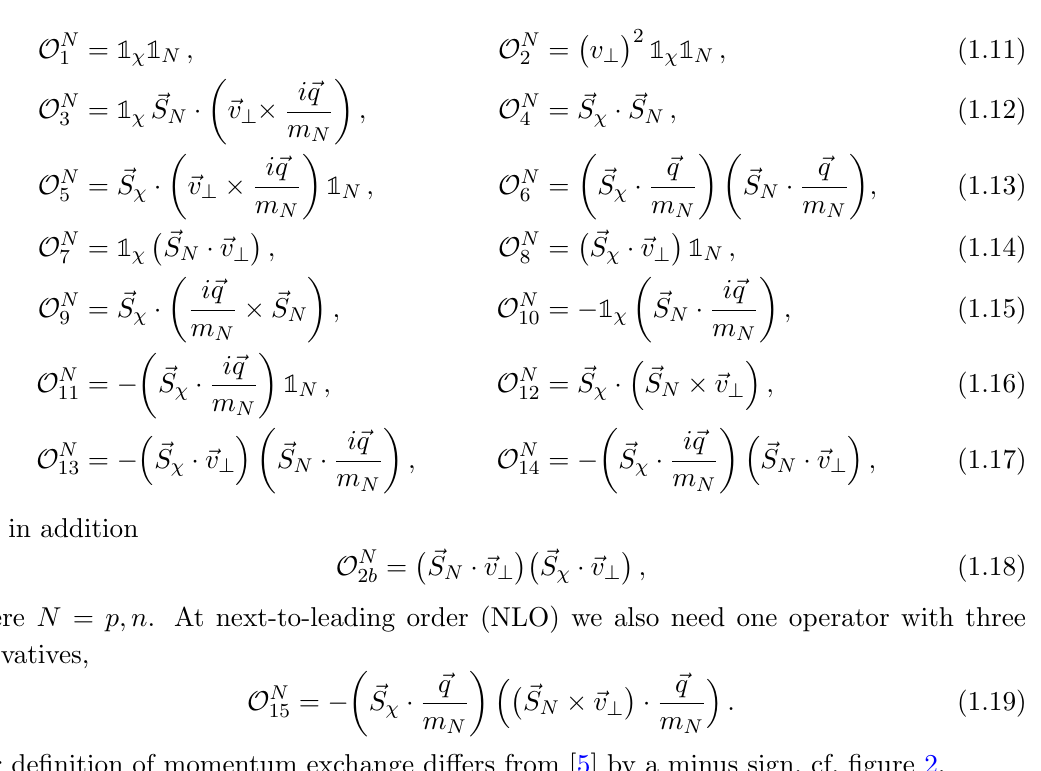
Figure 2 . The kinematics of DM scattering on nucleons, (cid:31) ( p 1 ) N ( k 1 ) most two derivatives